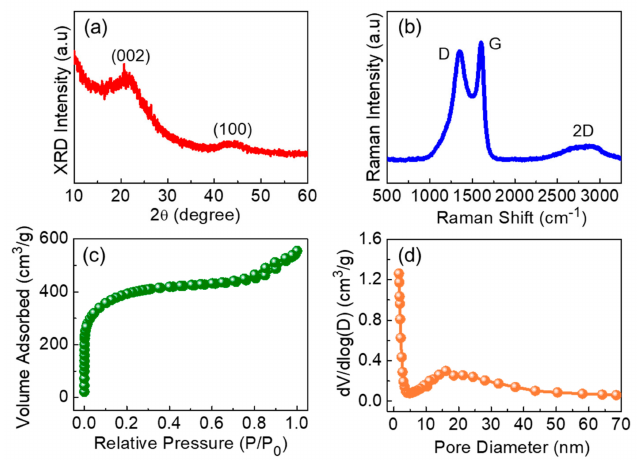
Figure 2. ( a ) X-ray diffraction (XRD) pattern, ( b ) Raman spectrum, ( c ) N 2 adsorption–desorption isotherm characteristics, and ( d ) pore size distribution of the IMP-GC nanoflakes derived from waste green tea.